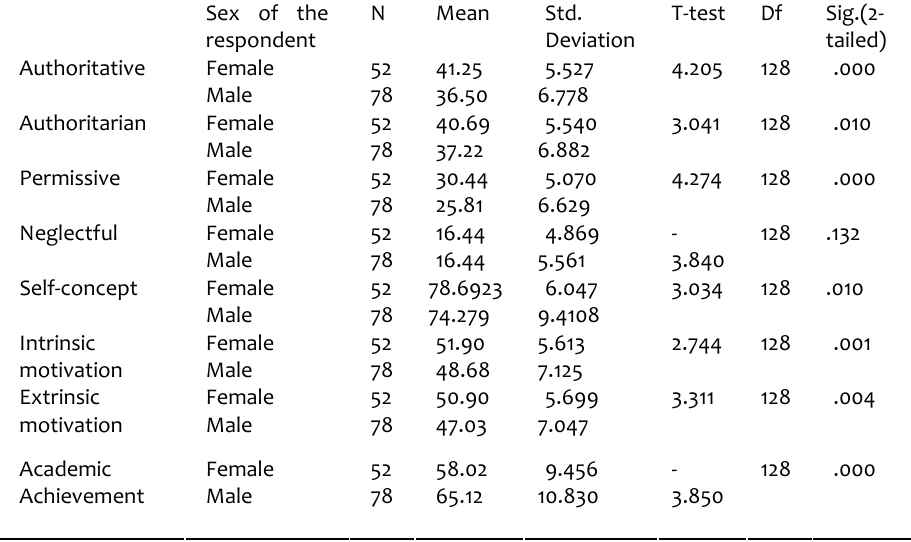
Table 6: Gender Difference in Predictor Variables and Academic